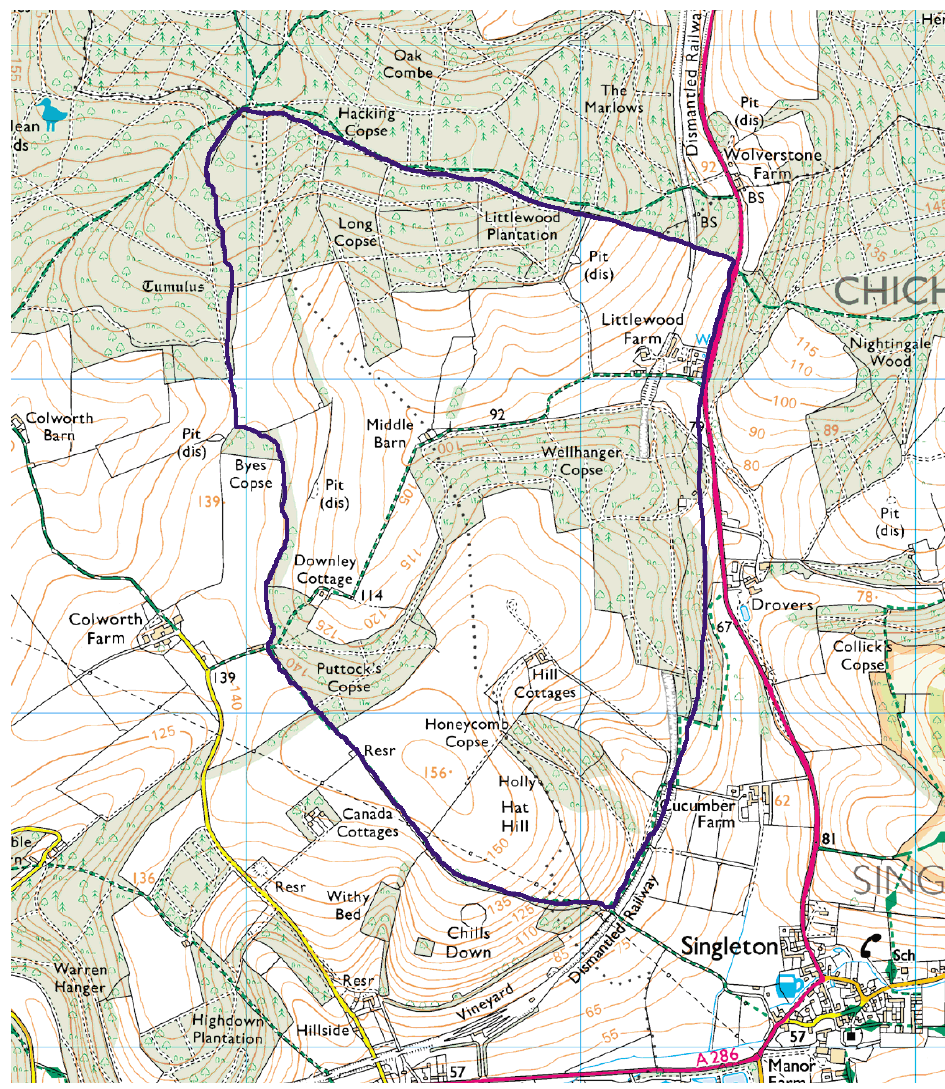
Fig. 2: Map showing the location, boundary and topography of the Downley deer park, to the NW of the village of Singleton. Blue squares = 1km 2 . (Contains Ordnance Survey data © Crown copyright and database right